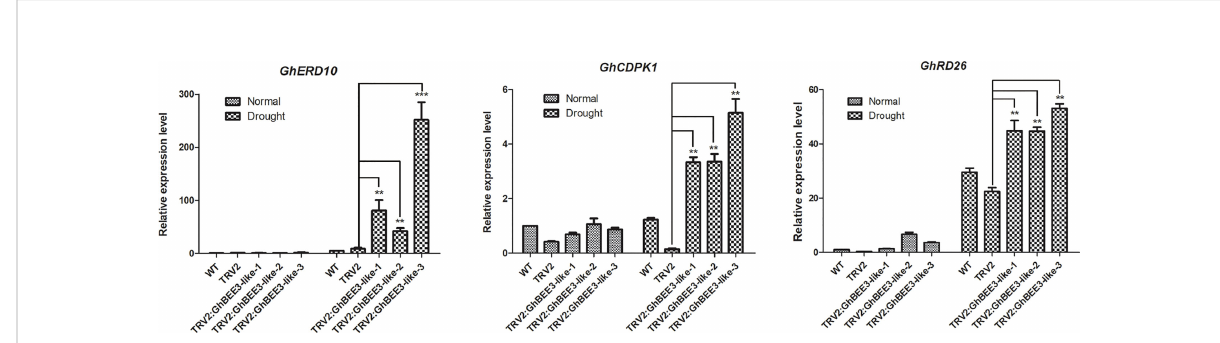
FIGURE 8 Expression analysis of stress-related genes in the WT cotton (CCRI24), TRV2 cotton (Control cotton) and TRV2:GhBEE3-Like cotton ( GhBEE3 knock-down cotton). The expression levels of stress-related marker genes, GhERD10 , GhCDPK1 and GhRD26 , were signi fi cantly higher in the TRV2:GhBEE3-Like cotton than in TRV2 cotton under drought conditions. Error bars represent the SD of three biological replicates. Student ’ s t - test, ** P<0.01, ***